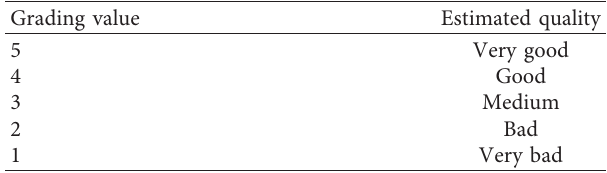
Table 2: Grading standards of ACR.